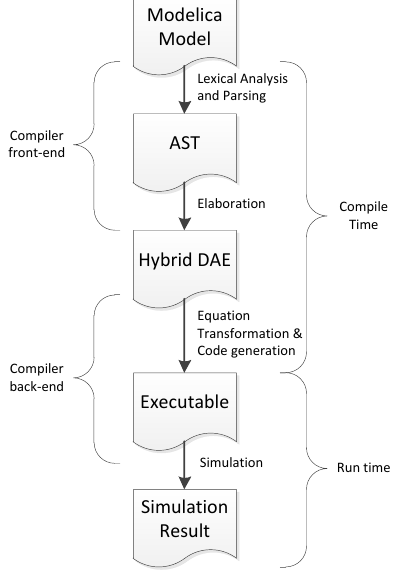
Figure 2: Outline of a typical compilation and simu- lation process for a Modelica language tool (Broman, 2010, p.